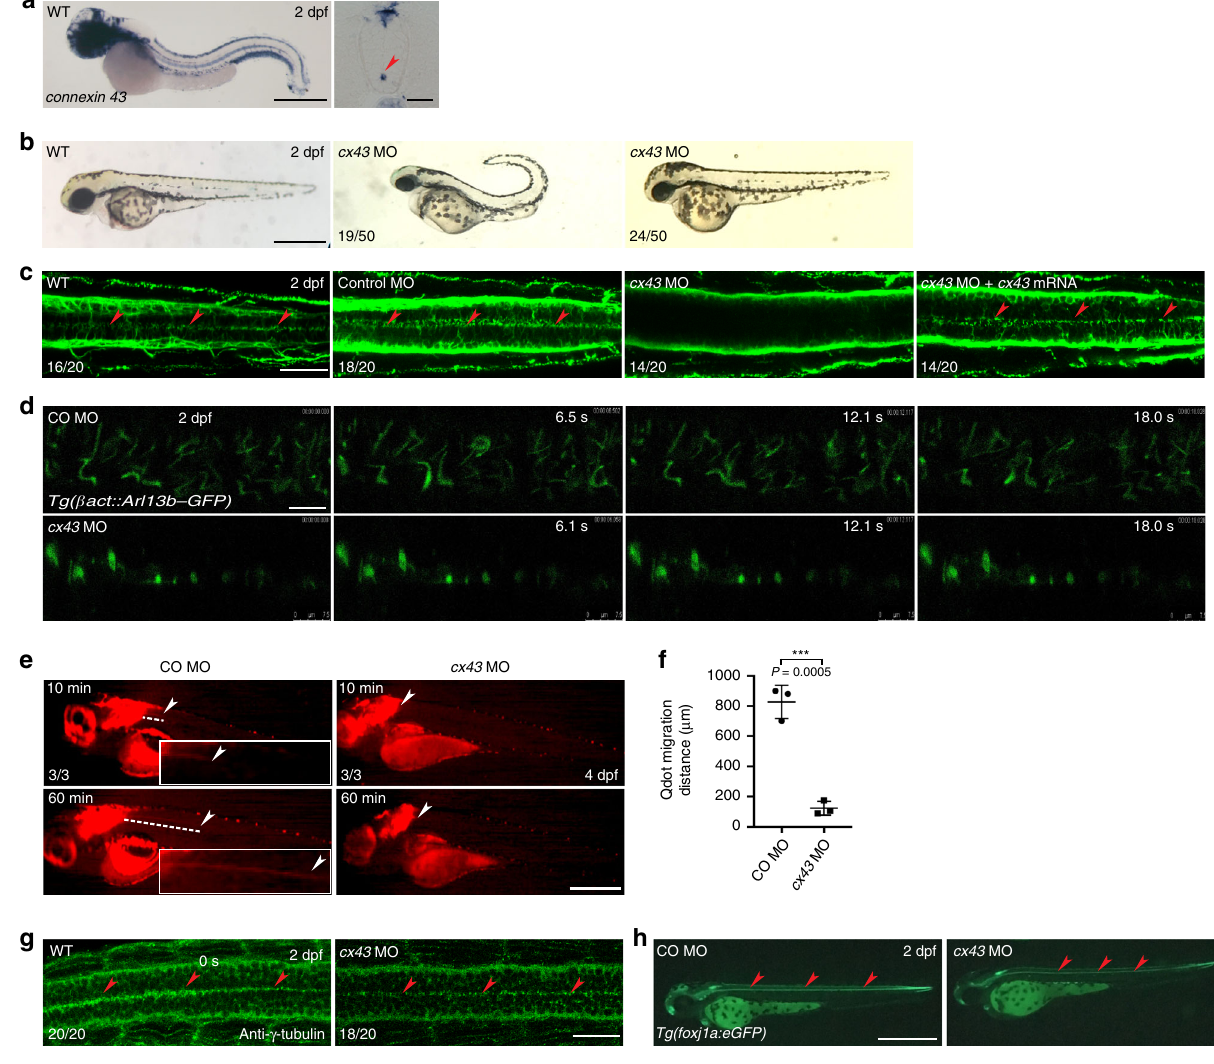
Fig. 3 Cx43 is implicated in the maintenance of ependymal motile cilia. a WISH of a WT embryo at 2 dpf with cx43 riboprobes (left). Lateral view anterior to the left. Right panel shows the cross-section image of the SC ventral to the bottom. Arrowhead indicates ECs. Scale bars = left: 650 μ m; right: 20 μ m. b Embryos at one-cell stage were microinjected with cx43 MO and imaged at 2 dpf. Lateral view anterior to the left. Scale bar = 650 μ m. c Embryos at one- cell stage were microinjected with either control MO or cx43 MO or cx43 MO + mouse Cx43 mRNA, and IF stained with anti-acetylated α -tubulin antibody at 2 dpf. Arrowheads represent spinal motile cilia. Dorsal view anterior to the left. Scale bar = 20 μ m. d Tg ( bactin2:Arl13b-GFP ) embryos expressing GFP in motile cilia were microinjected at one-cell stage with either control (CO) MO or cx43 MO and subjected to time-lapse imaging for 2 min (6.7 frames s − 1 ) with an intravital multiphoton microscope. Dorsal view anterior to the left. Scale bar = 7.5 μ m. e Embryos at one-cell stage were microinjected with control MO or cx43 MO and Qdots were microinjected into the hindbrain ventricles of larvae at 4 dpf, which were then imaged at 10 min and 60 min after the microinjection. Dashed lines indicate migration of Qdots. Arrowheads mark the caudal end of Qdot fl ow. Lateral view anterior to the left. Scale bar = 650 μ m. Insets represent magni fi cations of the dotted areas. CO: Control. f Quanti fi cation of Qdot migration distance in the larvae shown in d . Mean ± SD. *** P < 0.001 by two-tailed unpaired Student ’ s t test ( n = 3 larvae per group). g Embryos at one-cell stage were microinjected with either control MO or cx43 MO and immunostained with anti- γ -tubulin antibody at 2 dpf. Arrowheads indicate motile cilia. Dorsal view anterior to the left. Scale bar = 20 μ m. h Tg ( foxj1a:eGFP ) embryos expressing GFP in ECs were microinjected with either control MO or cx43 MO and imaged at 2 dpf. Arrowheads represent spinal ECs. Dorsal view anterior to the left. Scale bar = 650 μ